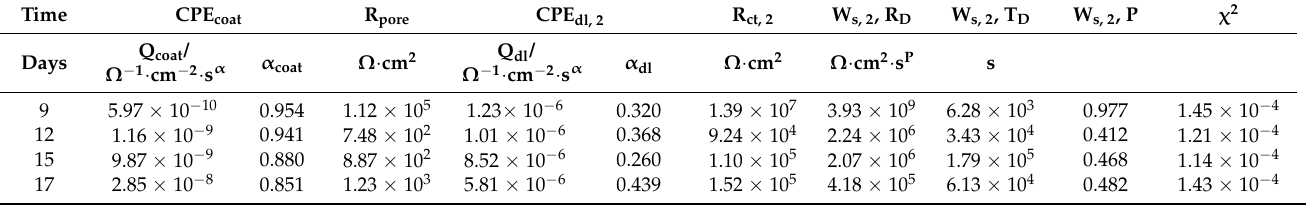
Table 5. Fitted values of EEC components for a coating prepared from the formula Zn–80%-PC, Stage 2.